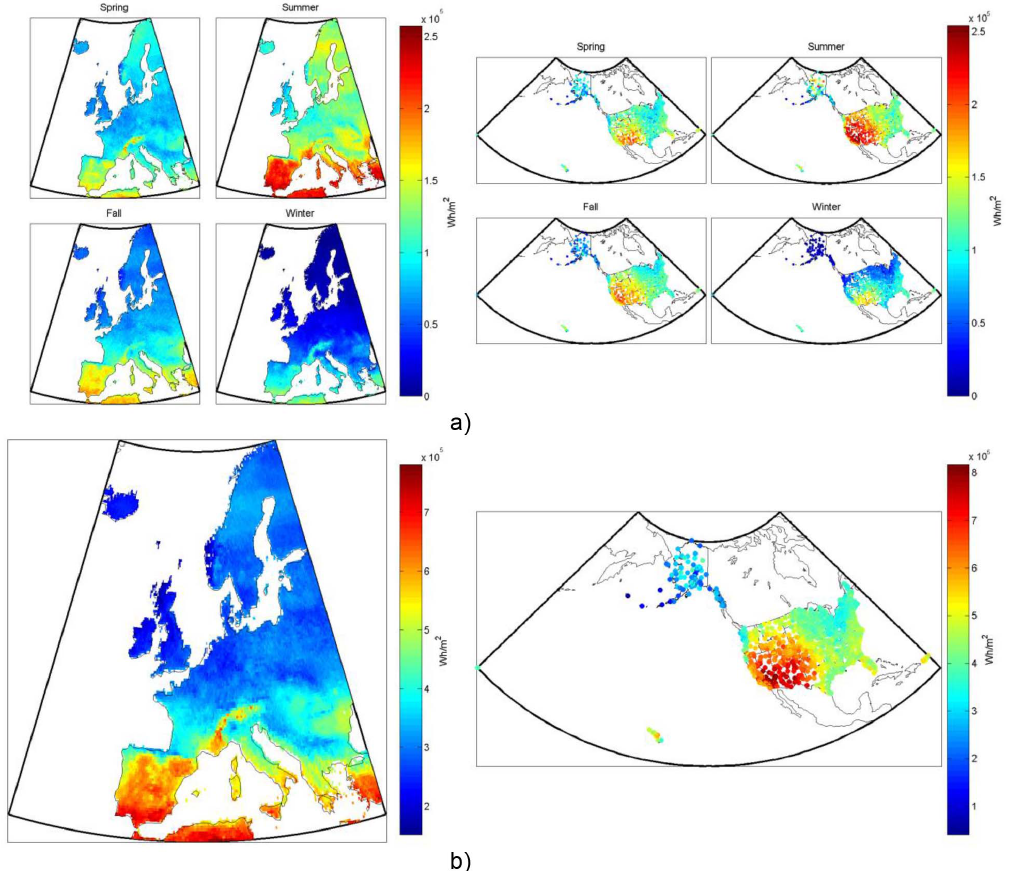
Figure 2. HCPV system’s electricity production, from one square meter of collector, both (a) seasonally and (b) annually in (left) Europe and (right) the US.